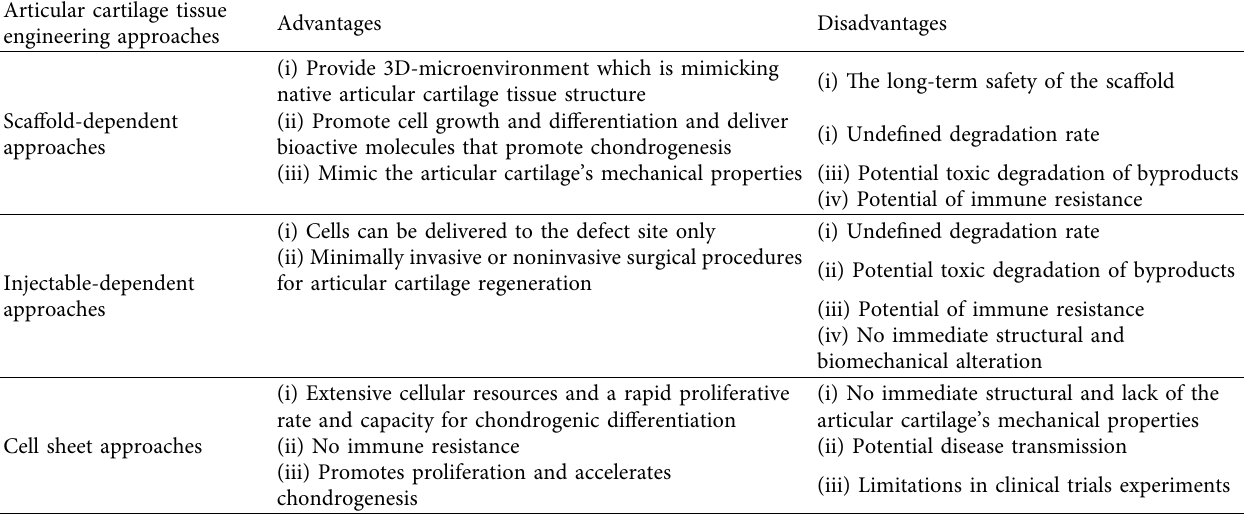
Table 1: Representative of advantages and disadvantages of articular cartilage tissue engineering approaches. Articular cartilage